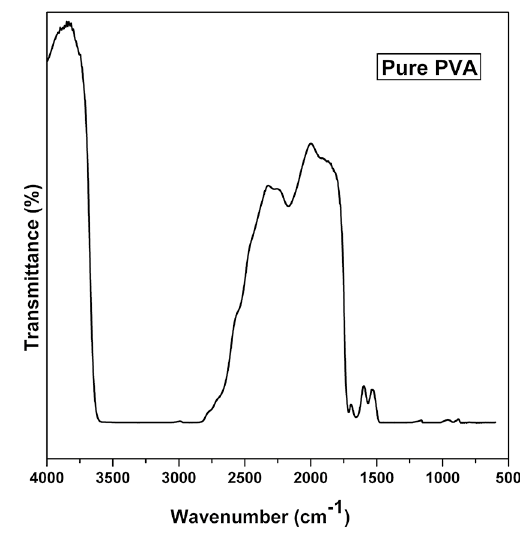
Figure 2. FTIR spectrum of pure